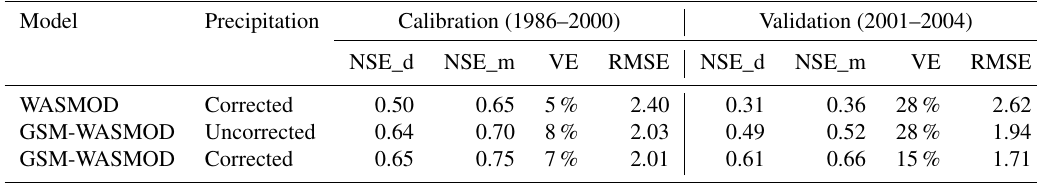
Table 5. Calibration and validation of WASMOD and GSM-WASMOD based on uncorrected and corrected precipitation. Model Precipitation